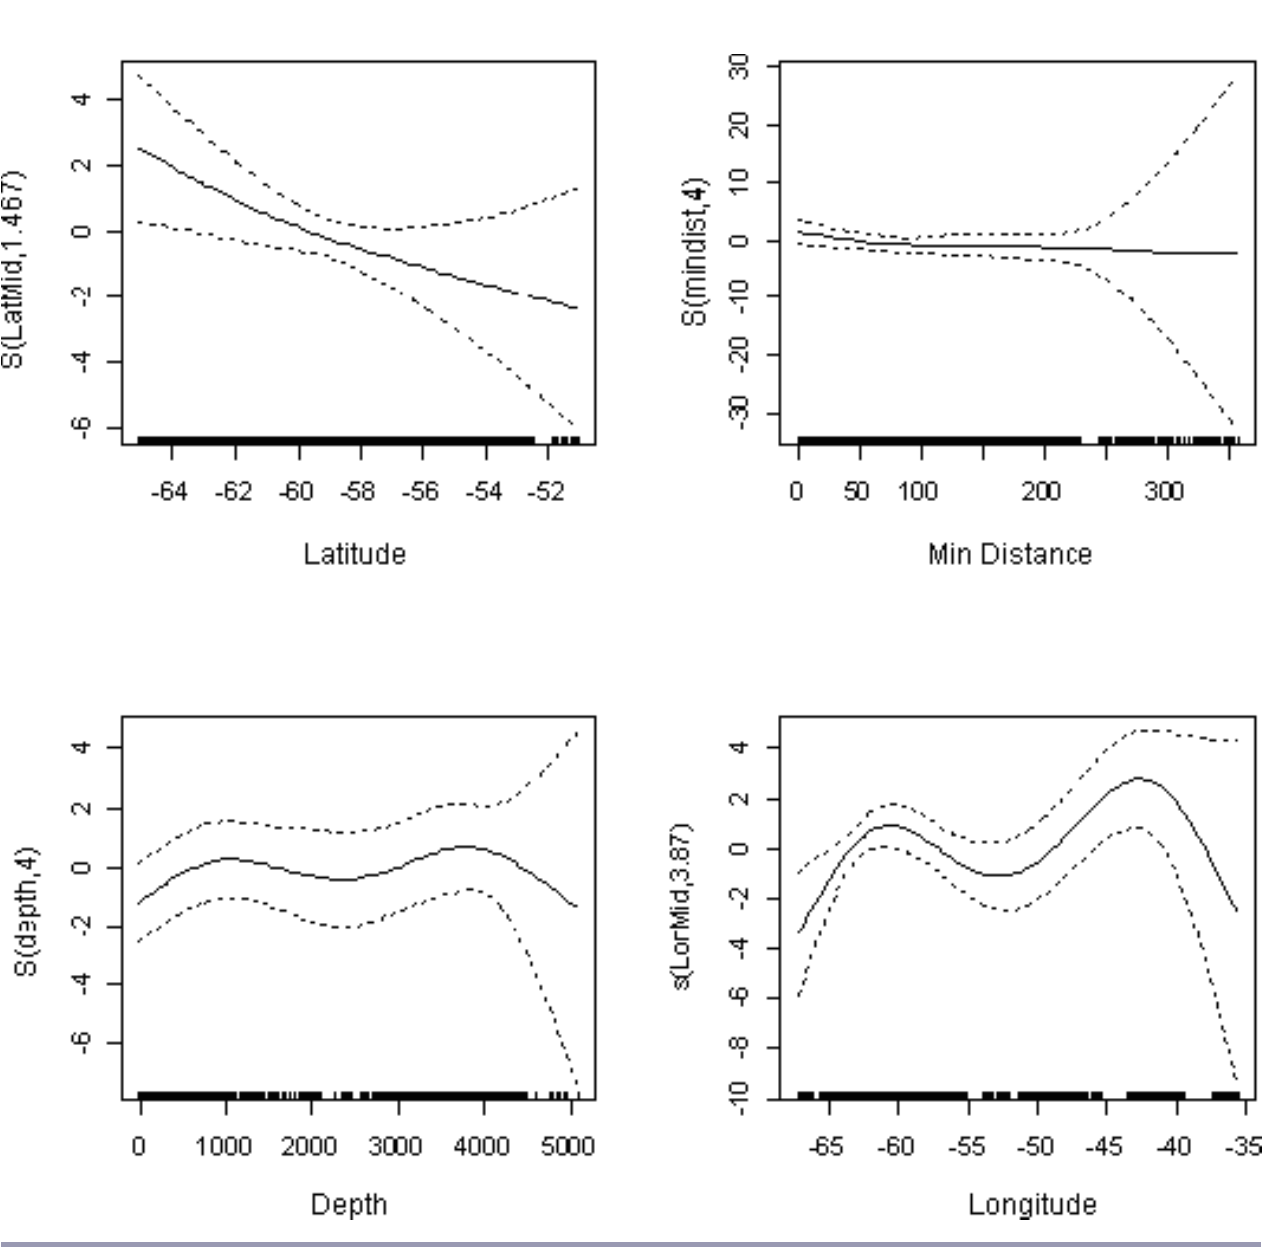
APPENDIX 2. Smoothed components (solid line) of four explanatory variables (x-axes) used in the